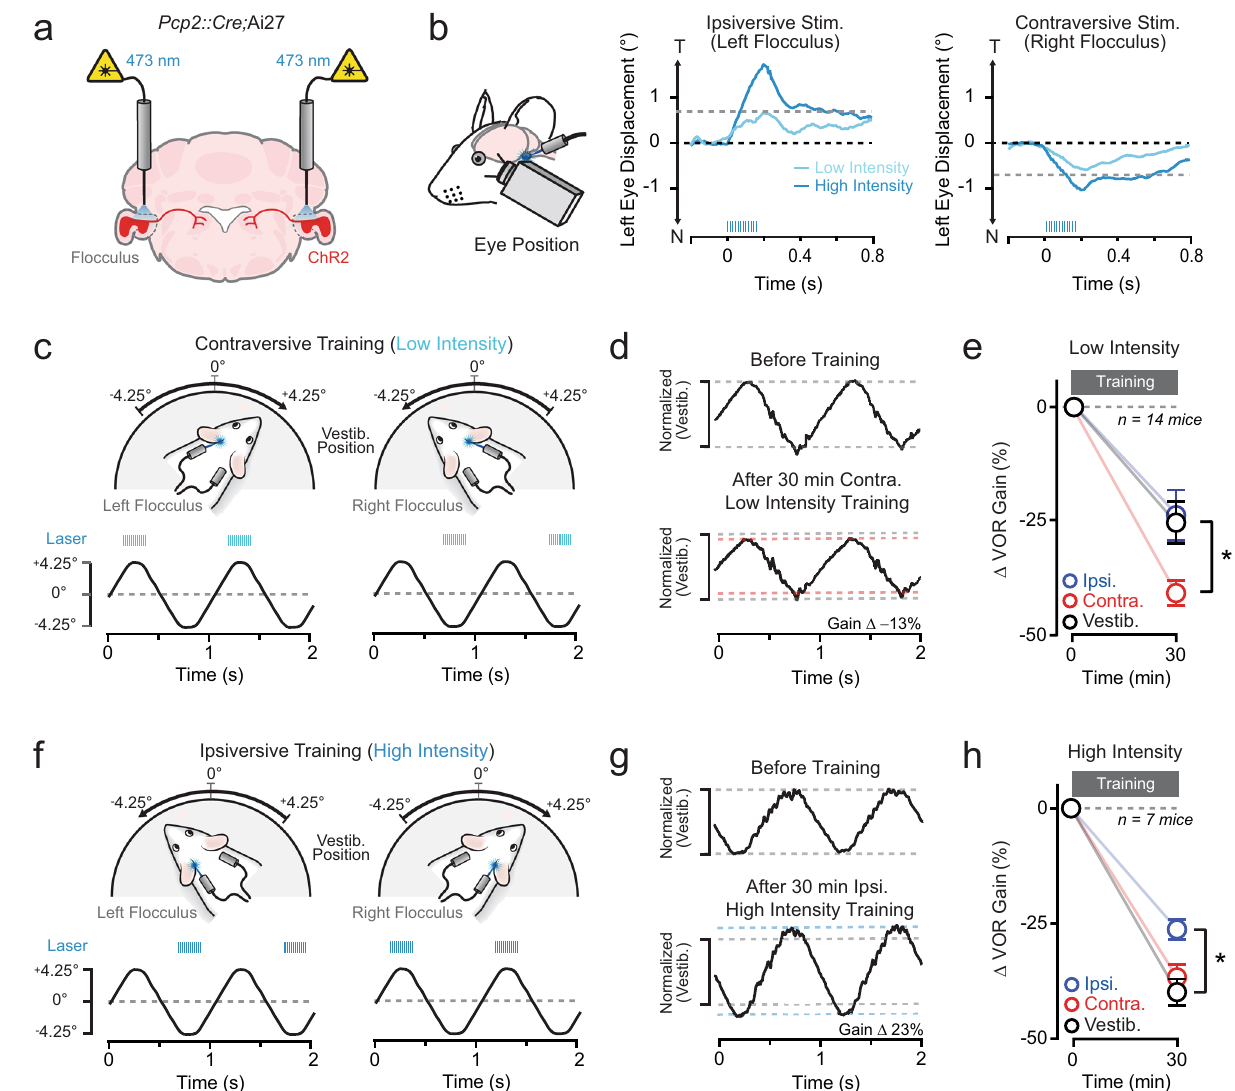
Fig. 3 Optogenetic PC activation induces VOR learning. a Optical fi bers targeting both fl occuli were bilaterally implanted into Pcp2::Cre; Ai27 mice to stimulate ChR2-expressing PCs. b Eye movements in a mouse evoked by unilateral optogenetic PC activation using different light powers ( λ 471 nm; 12 pulses; 5 ms; 50 Hz, 1 and 2 mW). The direction of lateral eye displacement (T, temporal; N, nasal) depended on whether PCs in the ipsiversive or contraversive fl occulus were stimulated (laser pulses indicated by blue tick marks). The absolute amplitude of evoked movements was used to categorize the intensity of optogenetic stimuli (> or <0.75°, high- and low-intensity, respectively). c In darkness, head- fi xed mice were trained by pairing sinusoidal vestibular motion (1 Hz) with a low-intensity optogenetic stimulus ( λ 471 nm; 12 pulses; 5 ms; 50 Hz) beginning near the completion of head turns (training lasted 30 min). In the example traces below, PC activation was timed to the end of contraversive vestibular motion (average head position, black trace; laser pulses; blue tics). d Average VOR-evoked eye movements measured before and after the mouse were trained with a pairing procedure using low- intensity optogenetic stimuli timed to the end of contraversive vestibular motion. The traces were normalized to that of time-matched, control responses recorded during sessions of training consisting of the vestibular stimulus alone. e The effect of pairing either contraversive or ipsiversive vestibular motion with low-intensity optogenetic stimuli on VOR gain, shown relative to control sessions. Measurements were obtained from the same mice. Changes are shown normalized to a baseline measurement obtained immediately before training ( t = 0 min) for each condition. Vestibular stimulation vs. ipsiversive stimulation: P = 0.6903; vestibular stimulation vs. contraversive stimulation: P = 0.0388. f In separate sessions, a cohort of the same mice was trained using pairing that included high-intensity optogenetic stimuli ( λ 471 nm; 12 pulses; 5 ms; 50 Hz). In the example head-position traces below, PC activation was timed to the end of ipsiversive vestibular motion. g Average VOR eye movements before and after training with high-intensity optogenetic stimuli timed to the end of ipsiversive vestibular motion. h The effect of pairing vestibular motion with high-intensity optogenetic PC stimulation on VOR gain across mice. Vestibular stimulation vs. ipsiversive stimulation: p = 0.0068, Vestibular stimulation vs. contraversive stimulation: P = 0.1151. Data are shown mean ± SEM with an asterisk indicating P < 0.05, two-way repeated-measures ANOVA with Dunnett ’ s post